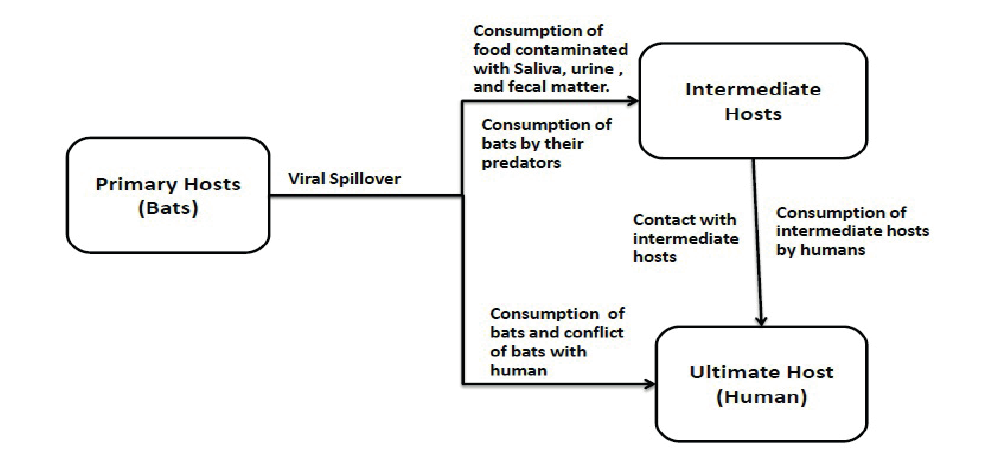
Figure 1. Possible transmission routes of bat-borne